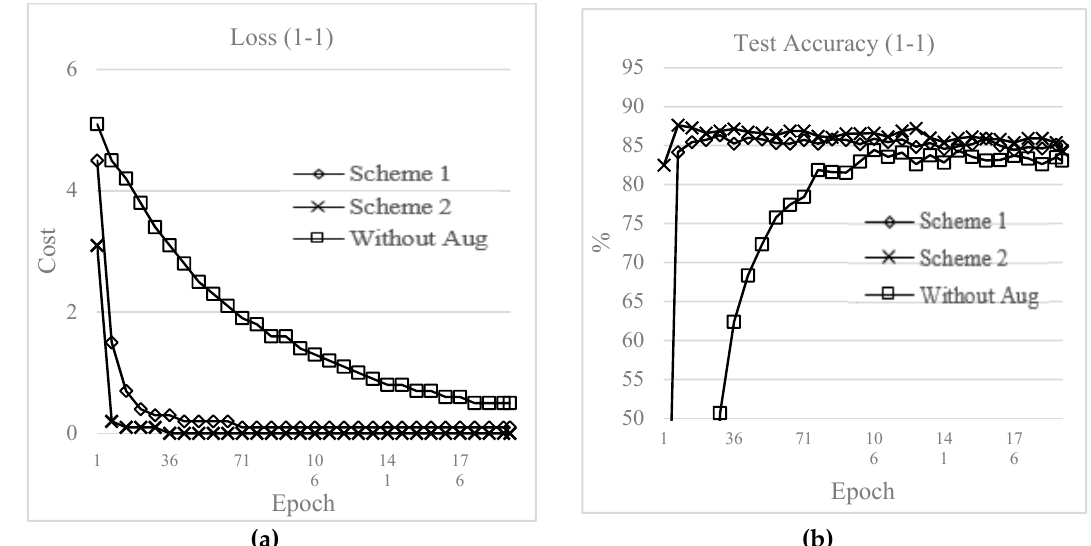
Figure 13. Lab simulation results. ( a ) Set 4 loss and ( b ) Set 4 lab simulation test accuracy.